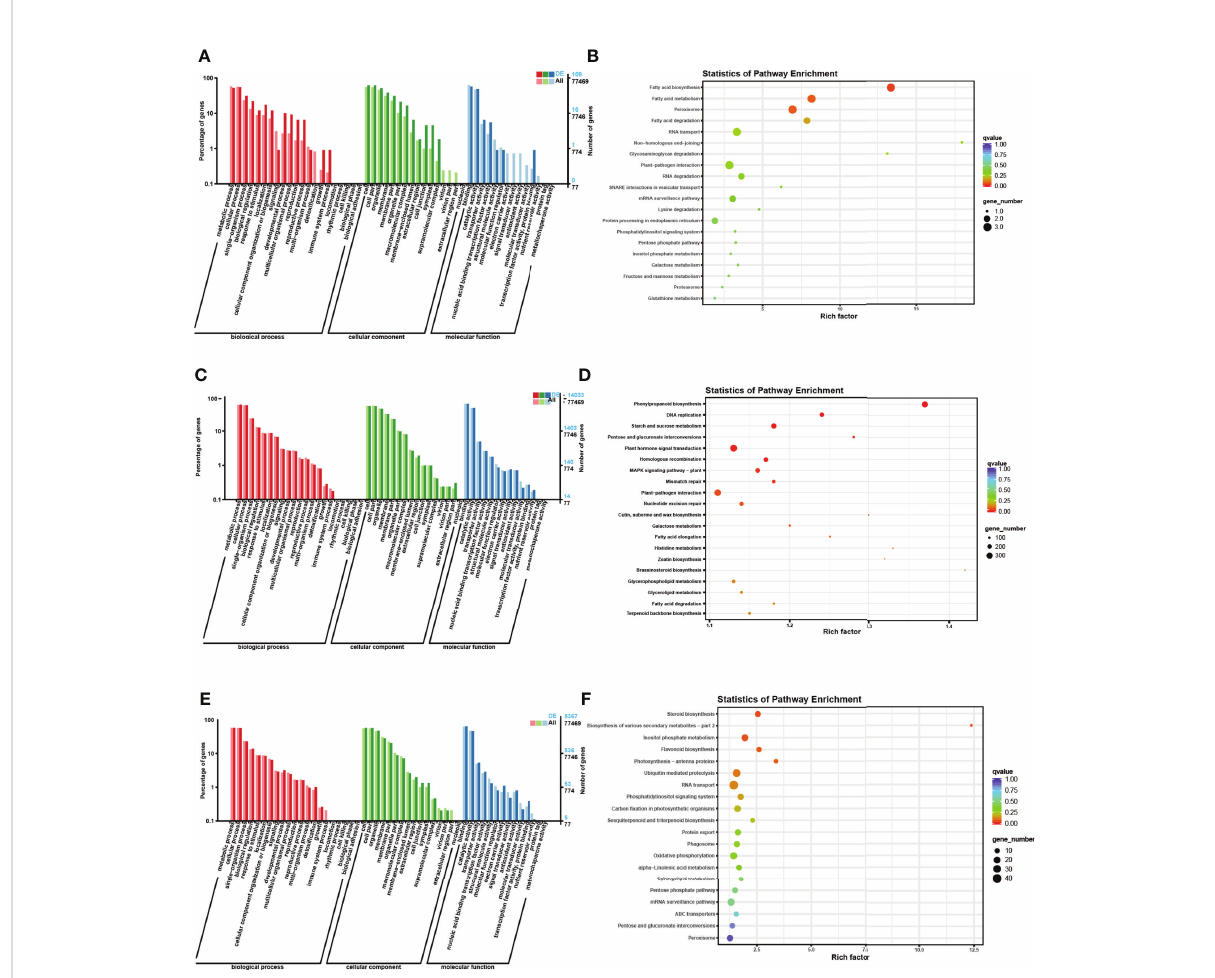
FIGURE 6 GO and KEGG enrichment analyses of the host genes of DE RNAs separately. (A) GO enrichment analysis of the host genes of DE circRNAs. The horizontal coordinate is the GO classi fi cation, the left side of the vertical coordinate is the percentage of the number of genes enriched in that GO term, and the right side is the number of genes. (B) KEGG enrichment analysis of the host genes of DE circRNAs. Each circle in Figure 6 represents a KEGG pathway, the vertical coordinate indicates the top 20 pathway names, and the horizontal coordinate is the enrichment factor, which represents the ratio of the proportion of differential genes annotated to a pathway (gene ratio) to the proportion of all genes annotated to that pathway (background ratio). The colour of the circle represents the q value, which is the P value after correction for multiple hypothesis testing, and the size of the circle indicates the number of genes enriched in the pathway. (C) GO enrichment analysis of the host genes of DE lncRNAs. (D) KEGG enrichment analysis of the host genes of DE circRNAs. (E) GO enrichment analysis of the host genes of DE miRNAs. (F) KEGG enrichment analysis of the host genes of DE